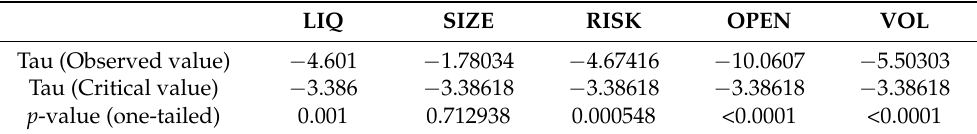
Table 2. Stationarity test, authors source.